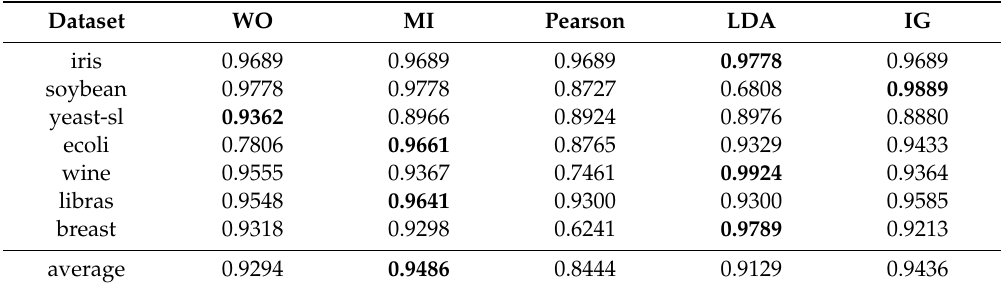
Table 5. Testing ACC obtained by SL-Scheme with di ff erent reduction techniques.